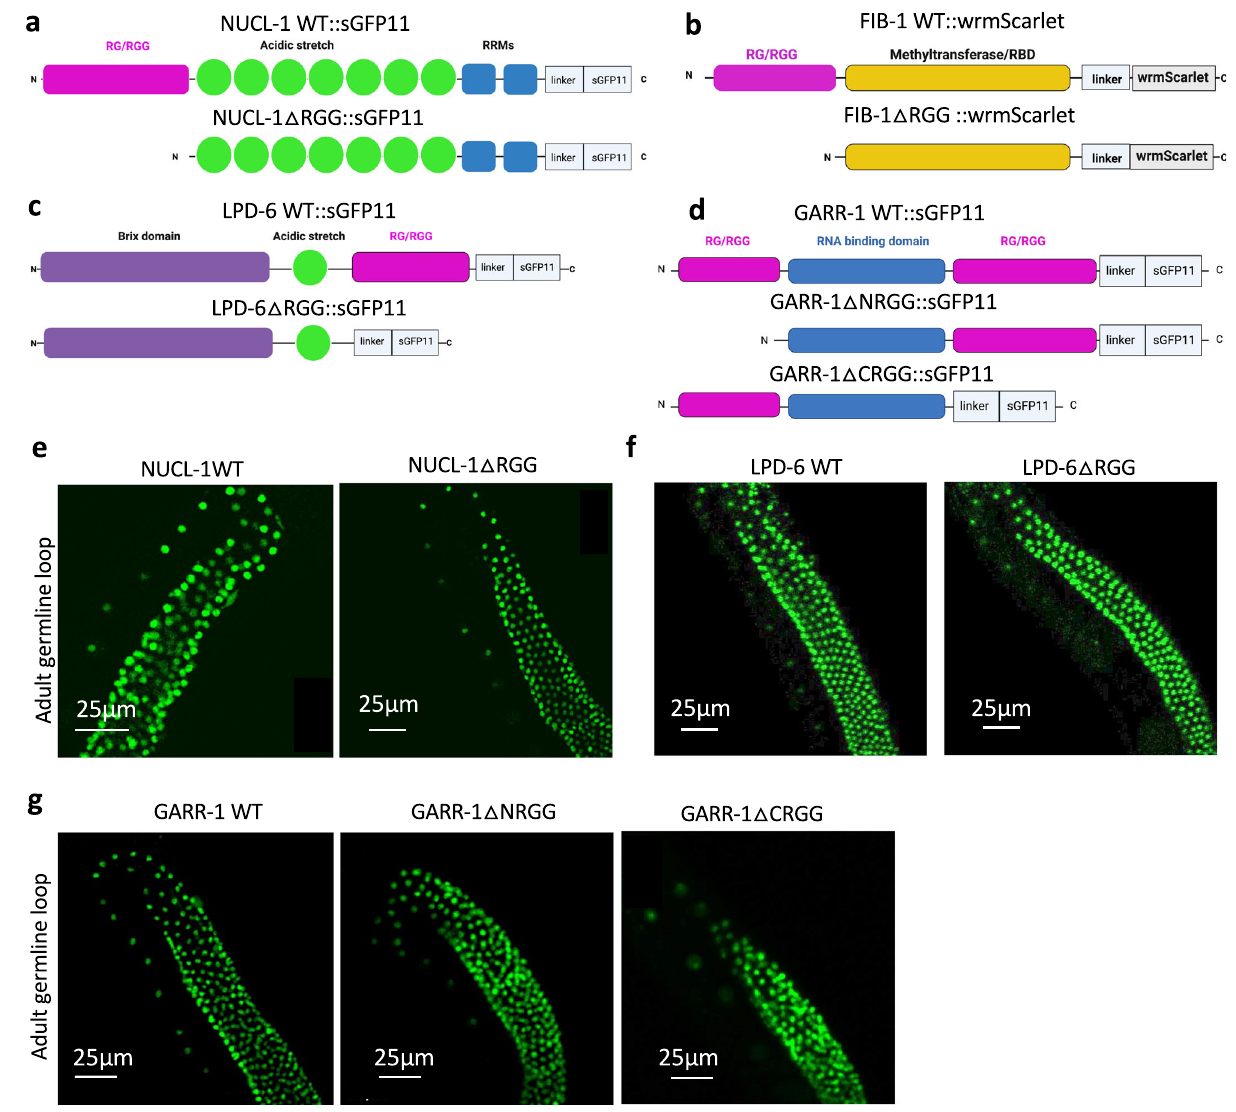
Fig. 3 | NUCL-1, GARR-1, and LPD-6 RG/RGG domains are not required for nucleolar accumulation. a sGFP11-tagged NUCL-1 and the RG/RGG domain dele- tion. b wrmScarlet-tagged FIB-1and the RG/RGG domain deletion. c sGFP11-tagged LPD-6 and the RG/RGG domain deletion. d sGFP11-tagged GARR-1 and the N- and